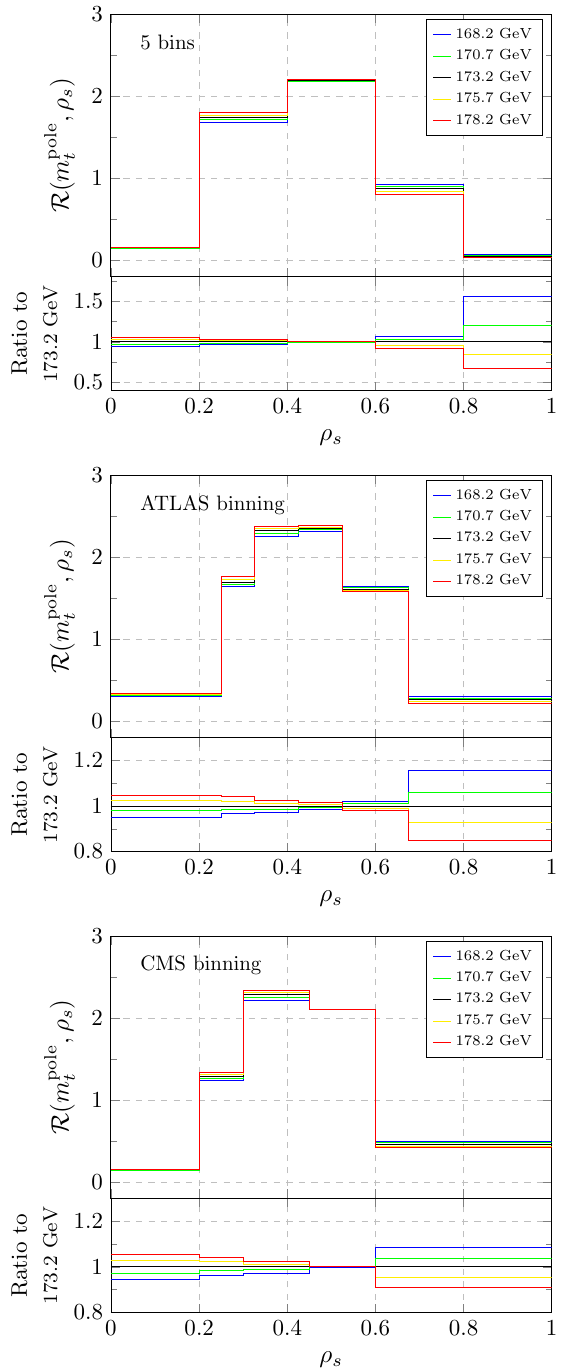
(cid:22) bj + X production + (cid:23) Figure 5 . Normalised (cid:26) s distribution at NLO QCD for the pp ! e e (cid:22) (cid:0) (cid:22) (cid:23) (cid:22) b process at the LHC with p s = 13 TeV. The Full case for (cid:12)ve di(cid:11)erent top quark mass values with various bin sizes is presented. We also plot the ratio to the result with the default value of m t , i.e. m t = 173.2 GeV. Renormalisation and factorisation scales are set to the common value (cid:22) R = (cid:22) F = (cid:22) 0 where (cid:22) 0 = H T = 2 and the CT14 PDF set is employed.